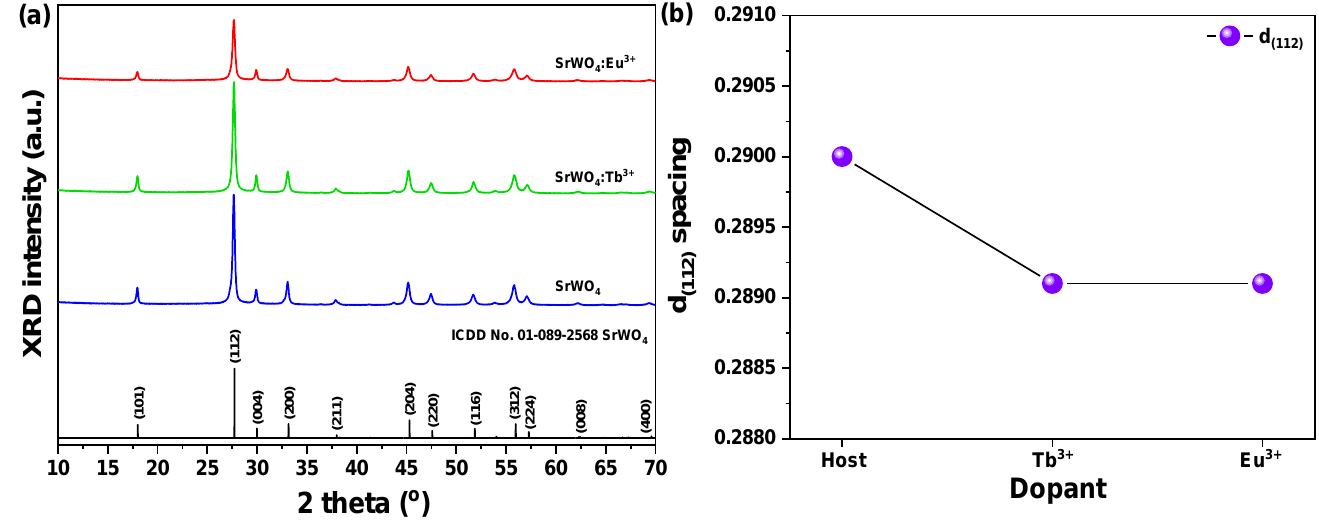
Figure 2. ( a ) XRD patterns, ( b ) d (112) spacing of SrWO 4 and SrWO 4 :RE 3+. Based on the ‘Lewis’s acid–base’ reaction, the samples synthesized by the The particle size of SrWO 4 was about 5.78 um in the longitudinal direction and about 2.36 um in the transverse direction (Figure 3(a)). Rare earth doped SrWO 4 :Tb 3+ particles were about 3.57 um in the longitudinal direction and about 2.29 um in the transverse di- rection (Figure 3(b)), and SrWO 4 :Eu 3+ particles had a size of about 4.82 um in the longitu- dinal direction and about 2.31 um in the transverse direction (Figure 3(c)). Krishna at al. reported BaMoO 4 is synthesized by reacting with MoO 4-2 , which is a monomer of oxyanion and grows in the vertical direction immediately after mixing the Ba aqueous solution and Mo aqueous solution. It is reported that the shape of the shuttle was clearly visible due to the larger rift in Oswald. It was synthesized using basic materials and explained by the action of the bases [26]. Figure 3. FE-SEM images of ( a ) SrWO 4 , ( b ) SrWO 4 :Tb 3+ , and ( c ) SrWO 4 :Eu 3+ samples. The host SrWO 4 showed absorption in a wide range, from 220 to 340 nm, and peaked at 277 nm. When the sample was excited at the highest peak of 277 nm, it was broad from 350 to 650 nm, and the peak at 492 nm showed blue – white emission spectrum (Figure 4(a)). Figure 4(b) shows the emission spectrum of SrWO 4 :Tb 3+ phosphor synthesized by doping Tb 3+ rare earth ions into SrWO 4 . The absorption spectrum of the phosphor powder under 544 nm showed that the band of charge-transfer transition (CTB) generated be- tween the O -2 and W 6+ of the WO 42- groups was widely distributed in the 210 ~ 290 nm region with a peak at 254 nm [27]. When the phosphor powder was excited with 254 nm, peaks at 487, 544, 586, 620, and 649 nm were observed in the emission spectrum. Among these peaks, the intensity of the green emission spectrum produced by the magnetic di- pole transition was the strongest. This emission intensity was 2.99 times stronger than the blue emission intensity produced by the electric dipole transition. The Tb 3+ ion in the